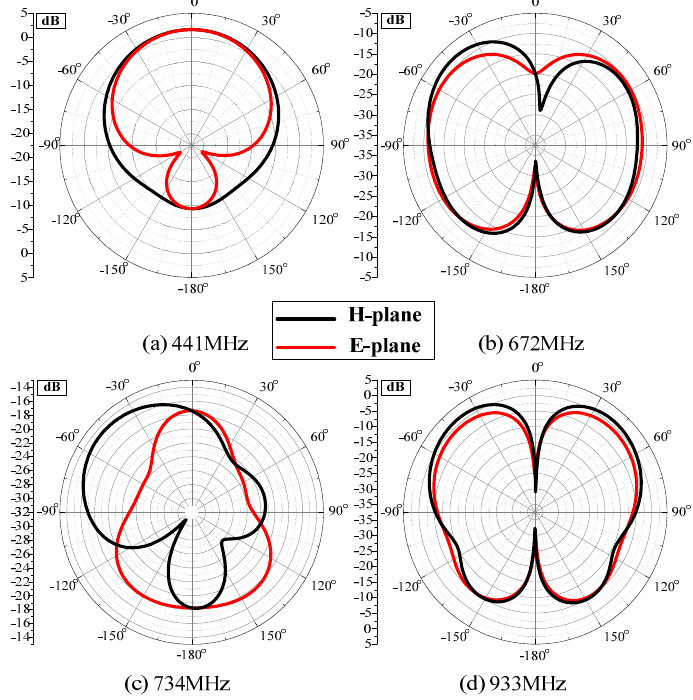
Figure 9. The antenna simulated radiation pattern in resonance points.